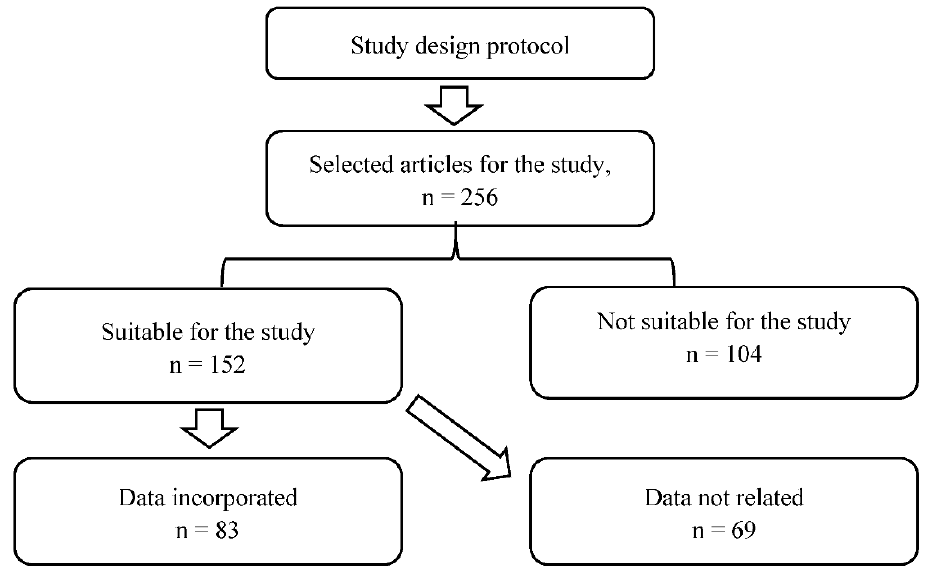
Figure 1. PRISMA protocol used for current study selection criteria.